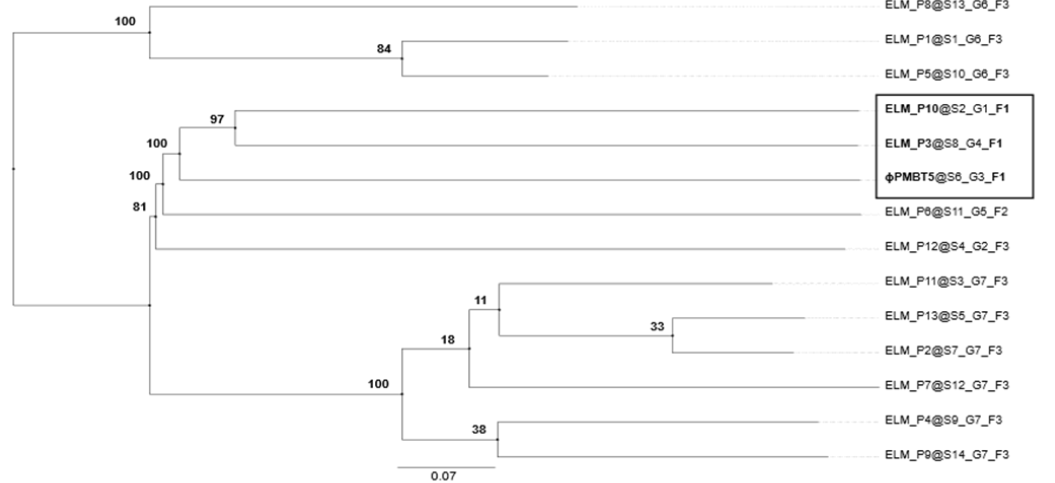
Table S1: Overview of the 44 putative ORFs in the genome of phage PMBT5 with their predicted function and the best match result in the databases using BlastP and HHPred.